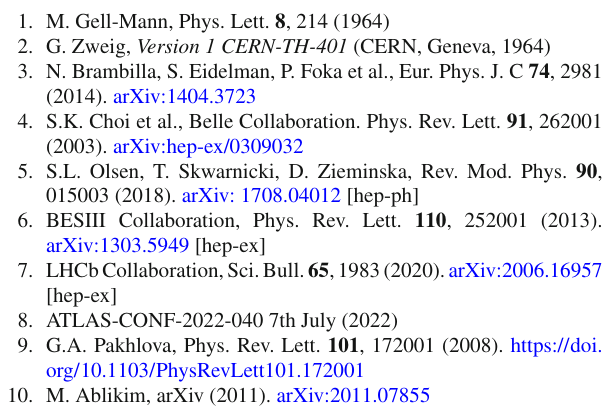
Table 4 Comparison of theoretical predictions for the masses of the ground states of the heavy tetraquarks. E b is the binding energy. δ 1 and δ 2 are the percentage difference between our results and Refs. [40,54].